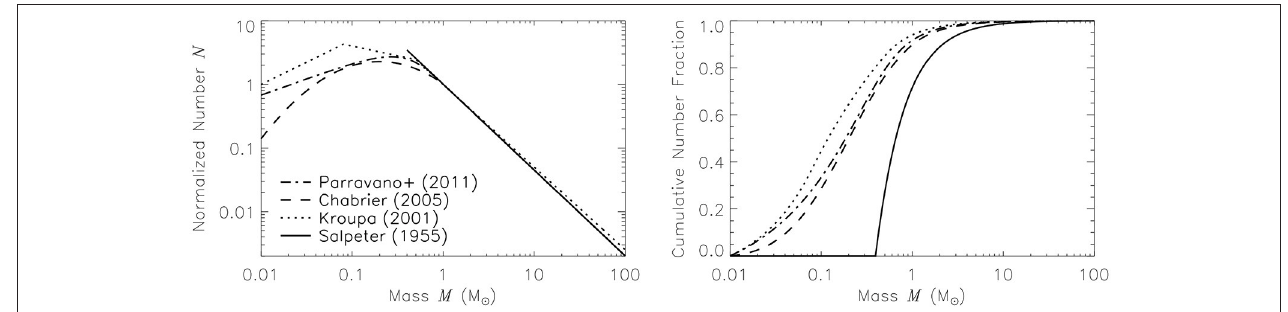
FIGURE 5 | Analytic fits to the observed IMF (left) and the cumulative mass function of stars (right) . Different lines show different parameterizations by Salpeter (1955) (solid), Kroupa (2001) (dotted), Chabrier (2005) (dashed), and Parravano et al. (2011) (dash-dotted). In this representation of the IMF, the number of stars is normalized such that N 1 for M 1M . While the high-mass tail ( M & 1M ) seems fairly universal, the low-mass end ( M . 1M = = ⊙ ⊙ with substantial variations in the number of low-mass stars and in the characteristic mass of the